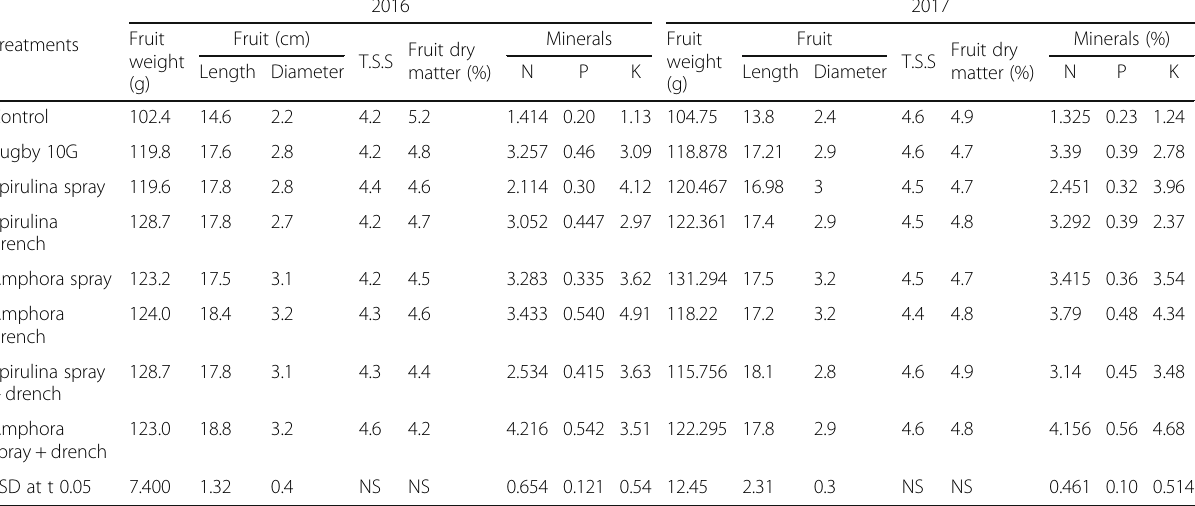
Table 4 Effect of algal treatments of cucumber Hesham hybrid compared with control and Rugby nematicide on fruit characters, total soluble solids, and NPK under infested soil with root-knot nematodes in 2016 and 2017